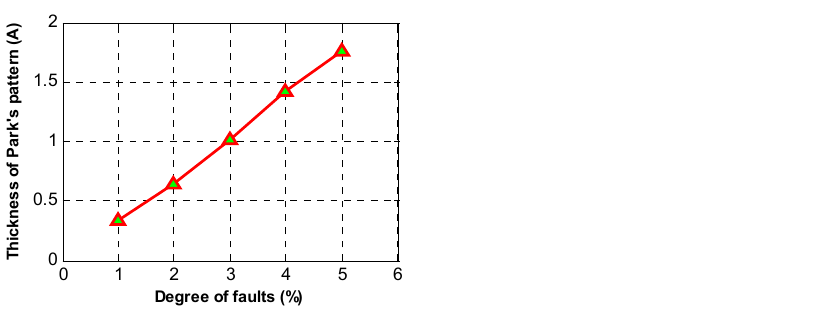
Figure 16. Influence of the degree of the rotor fault on the Park’s vector pattern thickness. Based on results from Table 5.